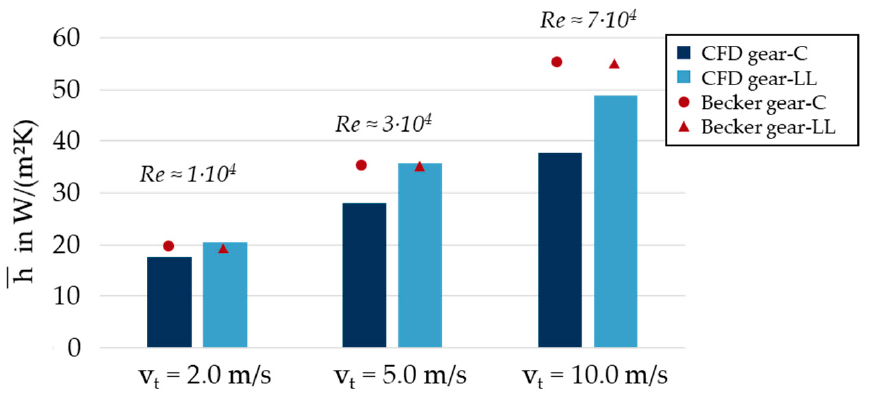
Figure 11. Surface-averaged HTC ℎ (cid:3365) for gear-C and gear-LL for circumferential speeds v t = {2.0; 5.0; 10.0} m/s in comparison to HTC based on Nusselt correlation according to Becker [15]. The results show that for circumferential speeds v t = 2.0…10.0 m/s, the